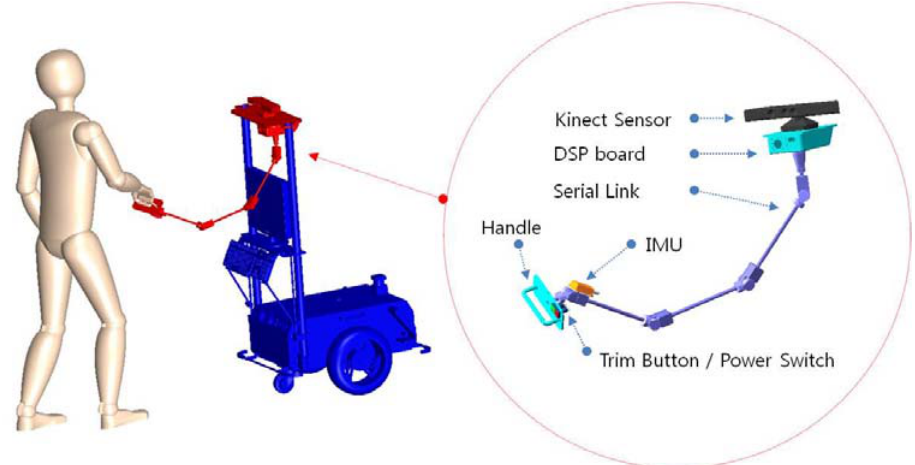
Figure 1. Intelligent lead and its